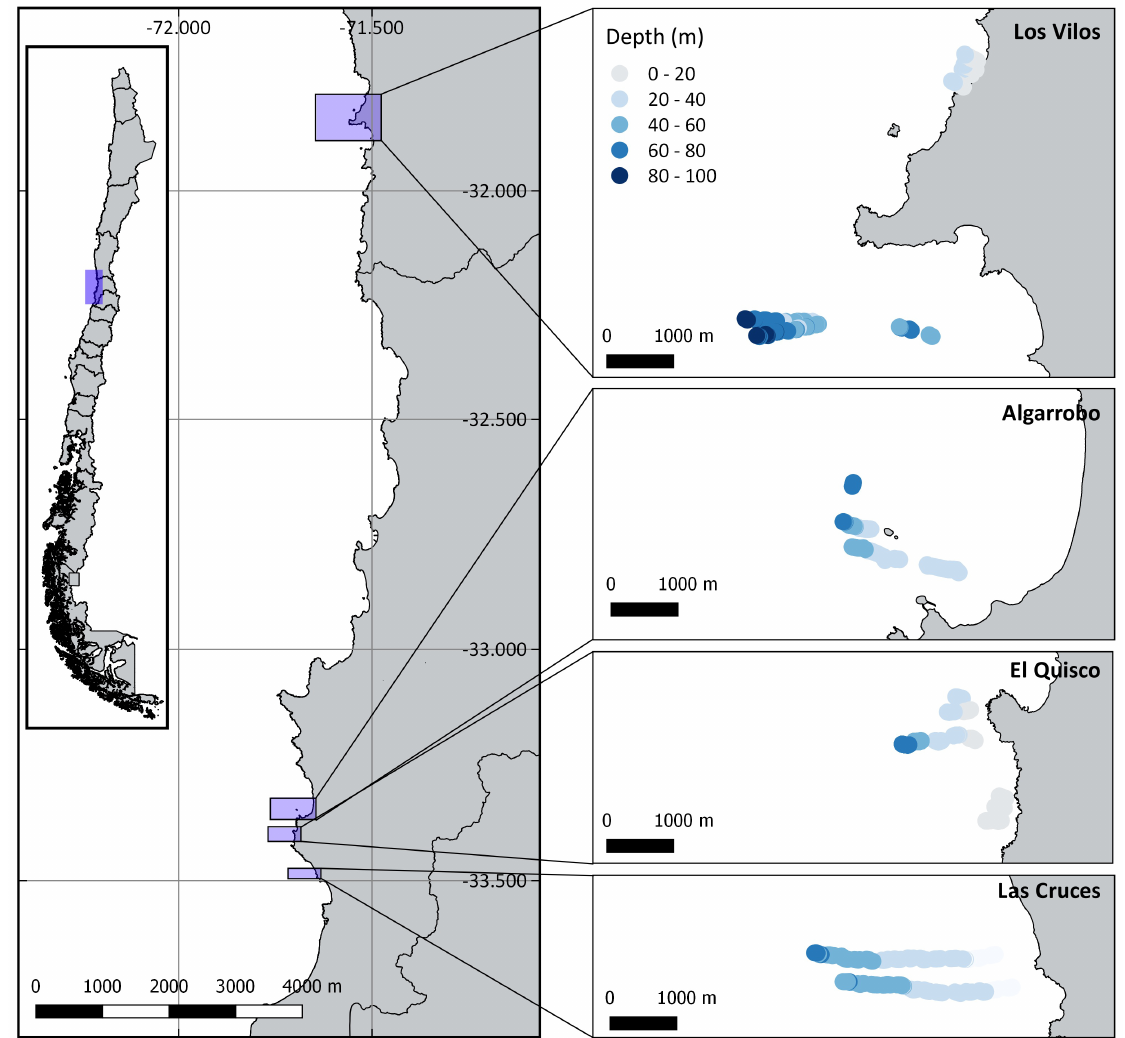
Figure 1. Towed underwater video transects performed at four sites: Los Vilos, Algarrobo, El Quisco and Las